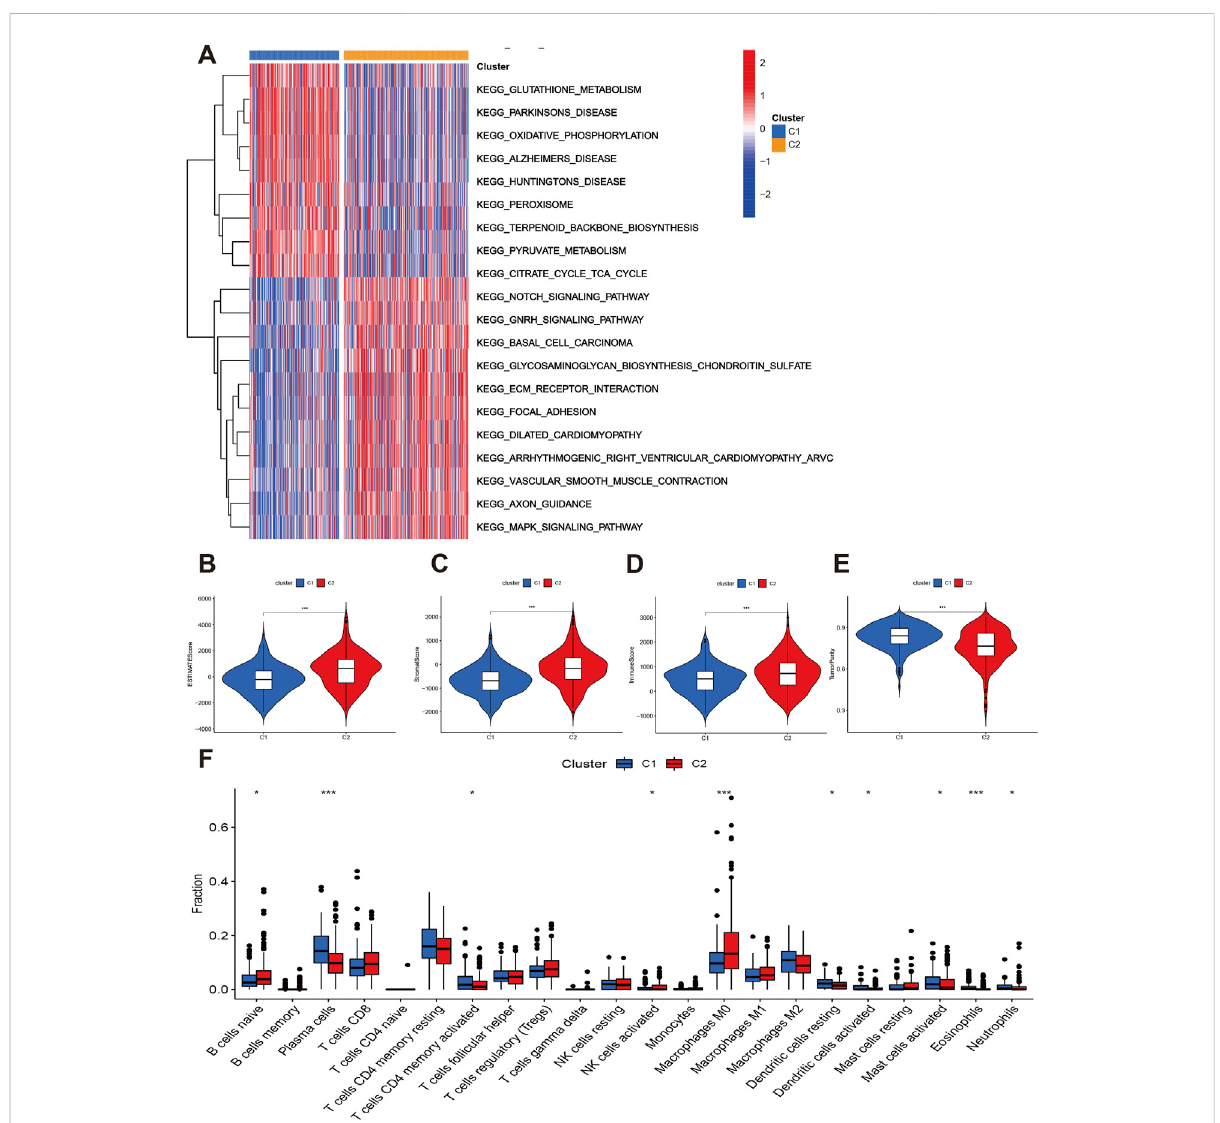
FIGURE 4 Functionenrichmentandimmunestatusoftwosubtypes. (A) GSVAshowedthedifferentiallyexpressedsignalingpathways. (B – E) Comparisons of immune in fi ltration levels between C1 and C2. (F) The in fi ltrations levels of immune cells between C1 and